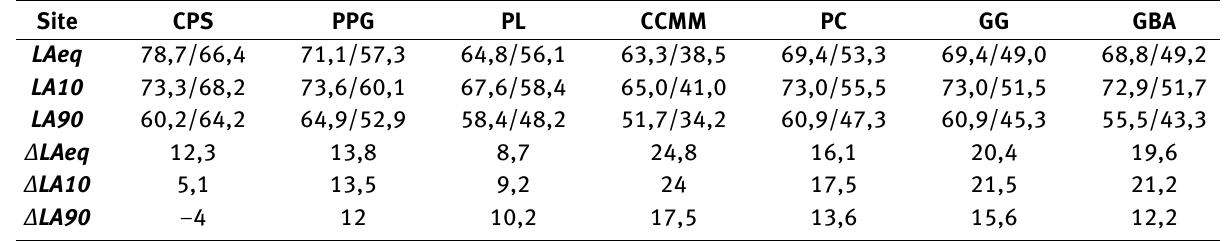
Table 2: Acoustic indicators outside/inside the 7 sites under investigation and related differences, in dB(A)